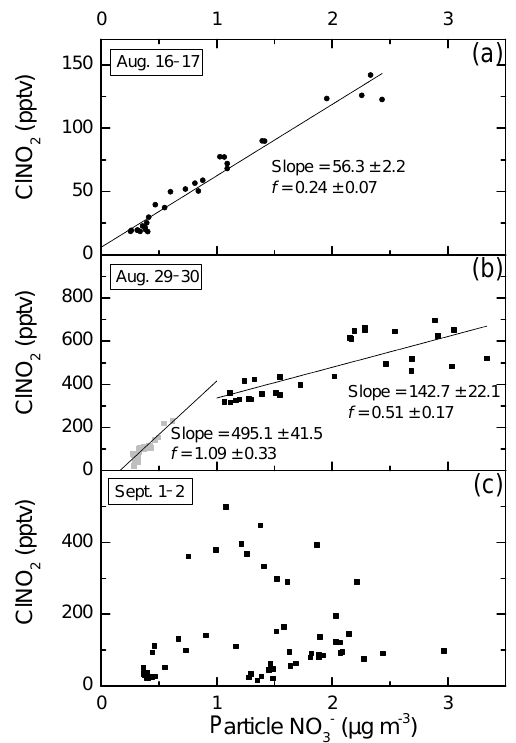
Figure 5. Plots of ClNO2 and NO − for three different campaign 3 nights. The slopes are converted to a fractional formation of ClNO 2 ( f ) via Eq.